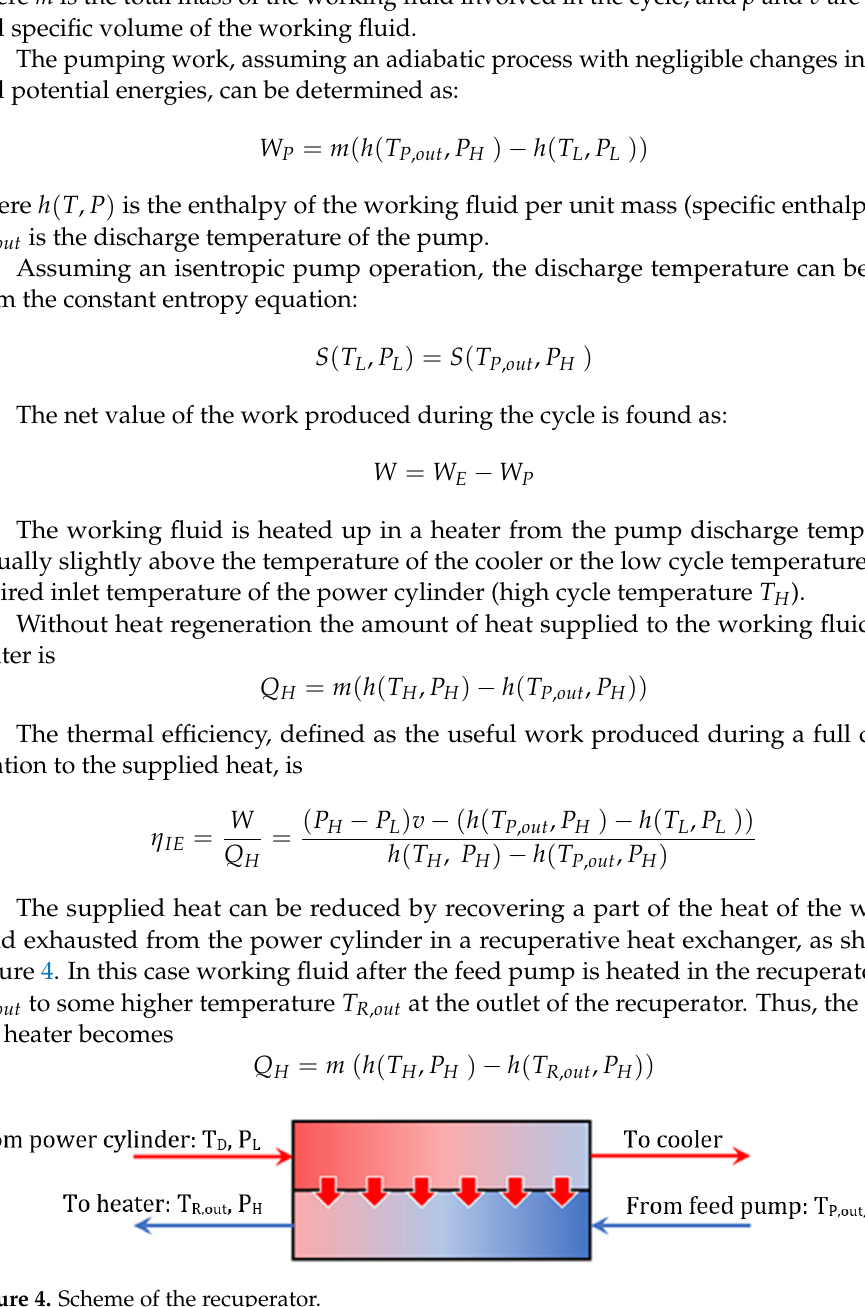
Figure 4. Scheme of the recuperator.